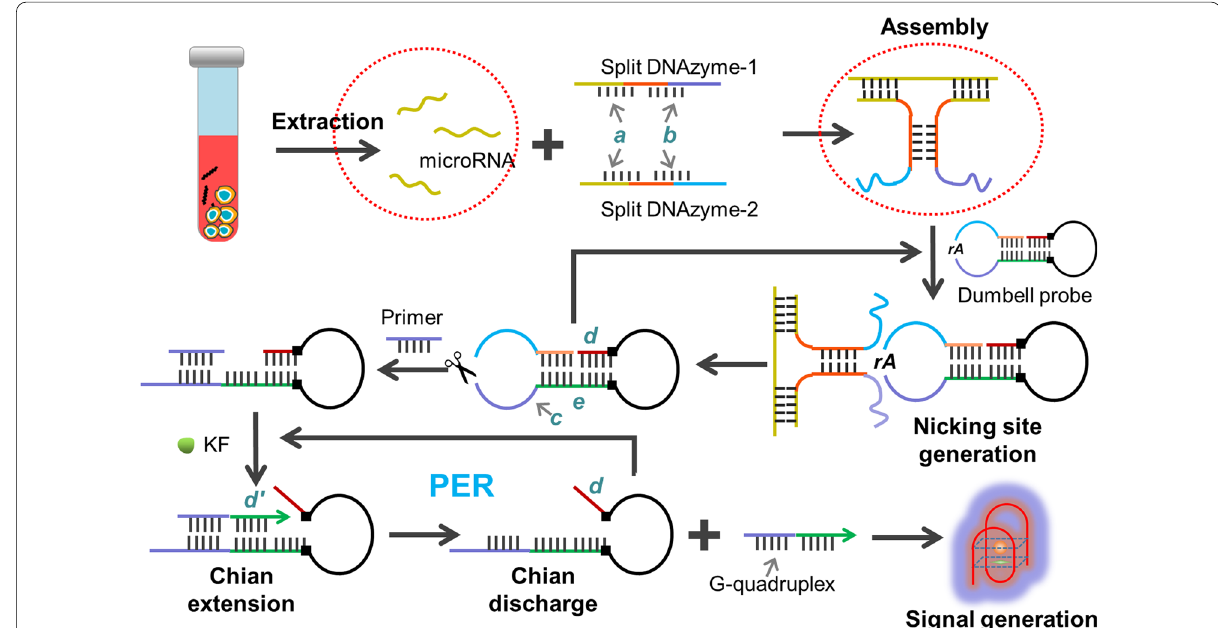
Fig. 1 The working principle of the established approach for the construction of PER-based miRNA detection